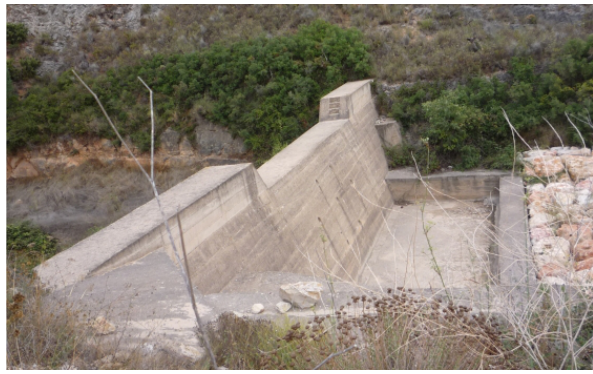
Fig. 4. The “main check